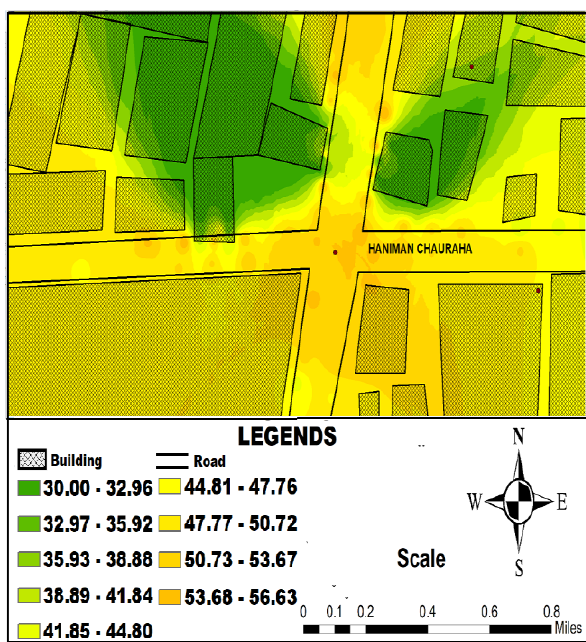
Figure 9. The noise map of Haniman Chauraha of evening slot with value variation is between 30.00 to 60.07. Barrier